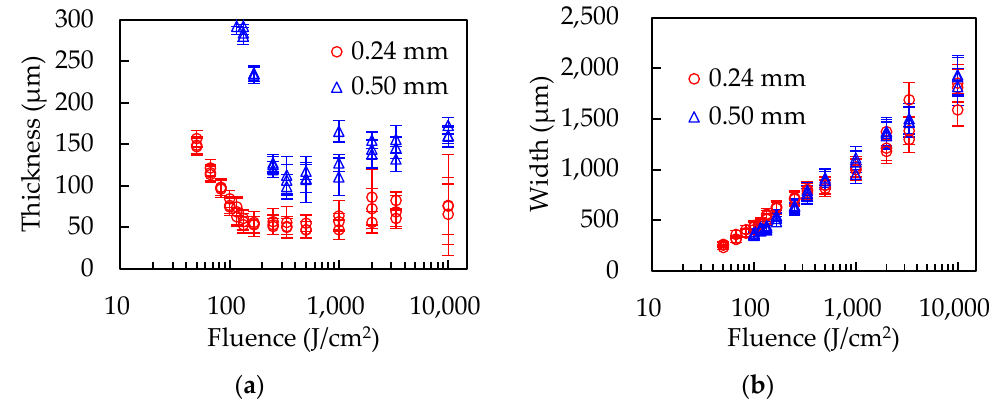
Figure 4. The results of ( a ) film thicknesses and ( b ) groove widths with the PP sheets 0.24 mm and 0.50 mm thick.